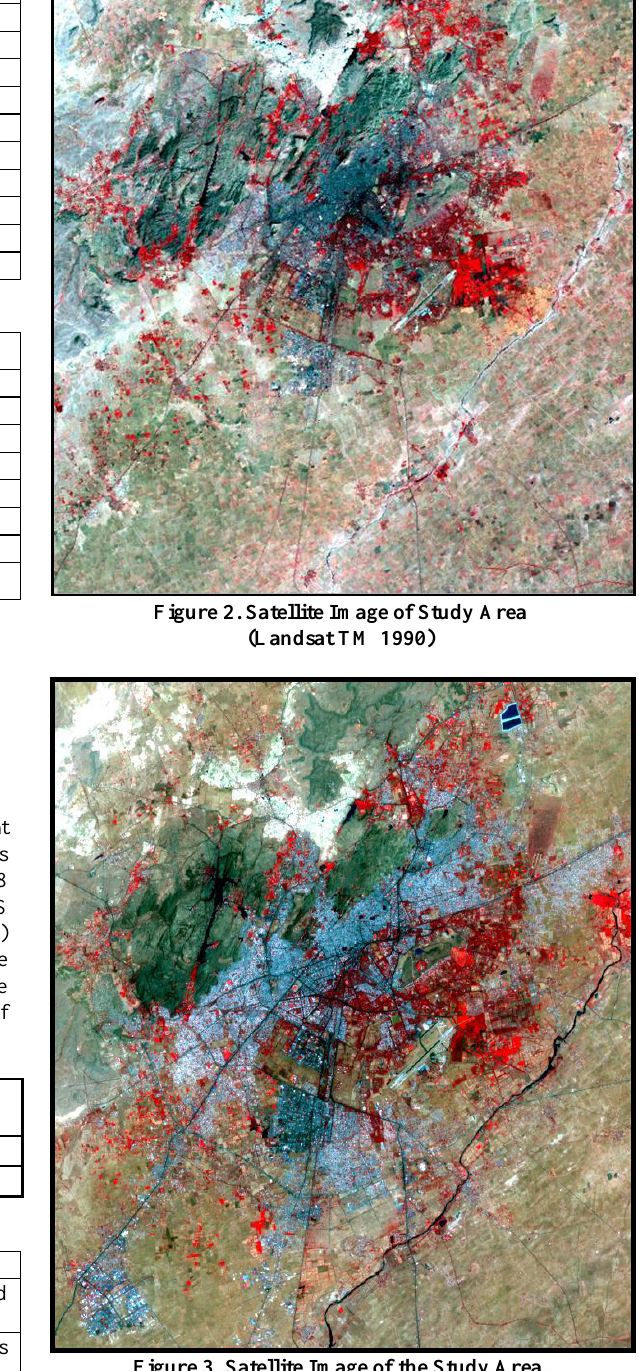
Figure 3. Satellite Image of the Study